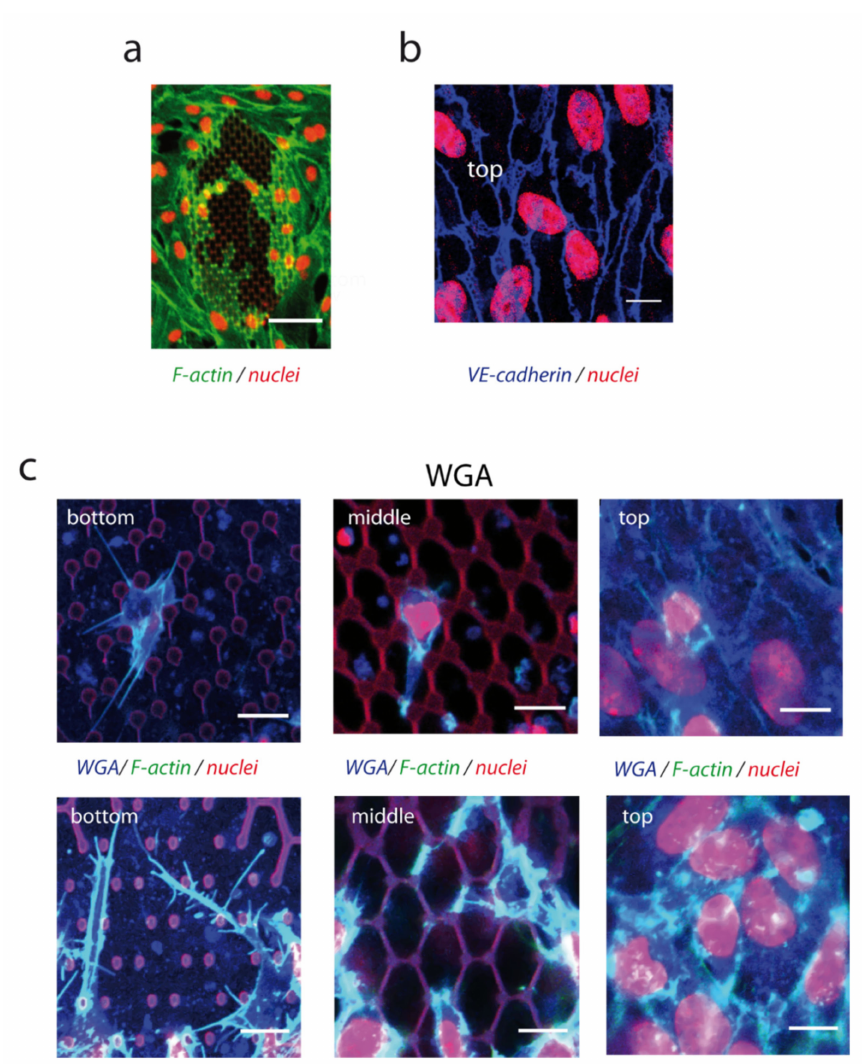
Figure A3. Early colonization and membrane labelling. ( a ) Early cell colonization on a l7L14-closed structure, VEGF 5 ng/mL. z projection is shown, red: nuclei, green: F-actin, bar 50 µ m. ( b ) Monolayer organization on top of a l7L14-closed structure: intercellular junctions labelled with VE-cadherin (blue). Nuclei in red. z projection of 3 planes above structure. Confocal image acquired from the top, bar 10 µ m. ( c ) Membrane labelling with WGA-FITC on a l7L14-open microstructure (WGA, blue; nuclei, red; F-actin, green). Top, early colonization (VEGF 5 ng/mL). Bottom, colonization with dactylopodia-like structures, culture in media without VEGF, same image as in Figure 3d, left, with additional WGA labelling. Bar 10 µ m. Cells fixed at time of structure colonization (2 ( a , b ), 3 ( c bottom) or 5 ( c top) days after cell